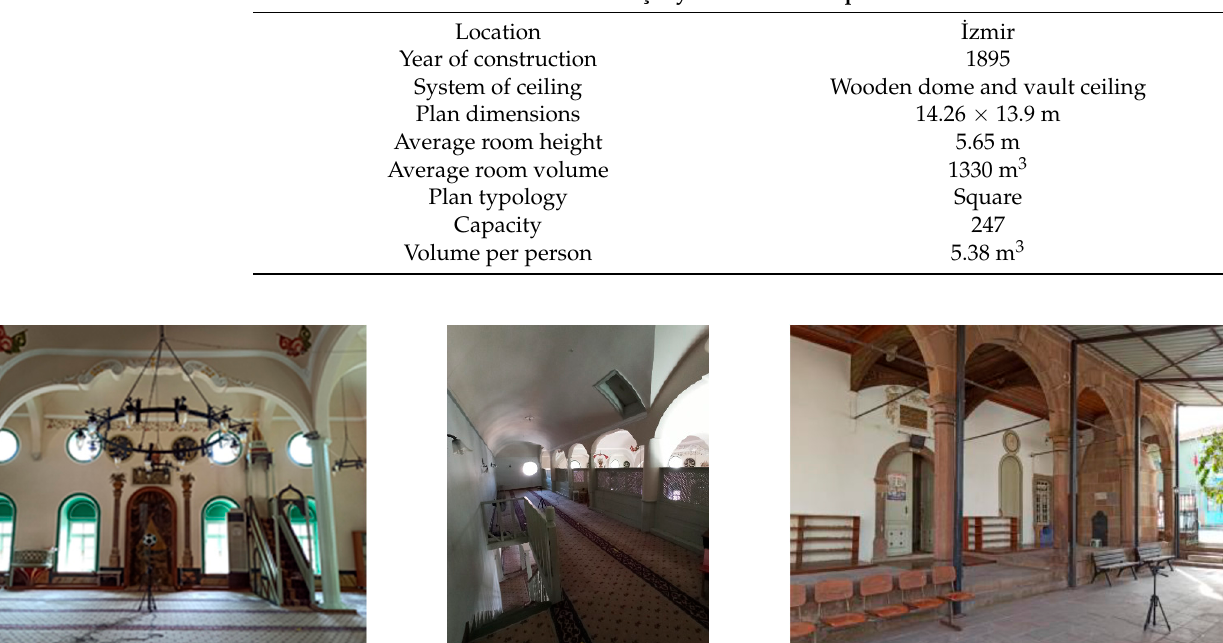
Figure 9. Main prayer hall and women’s prayer hall of Göçbeyli Mosque (photos by the authors).